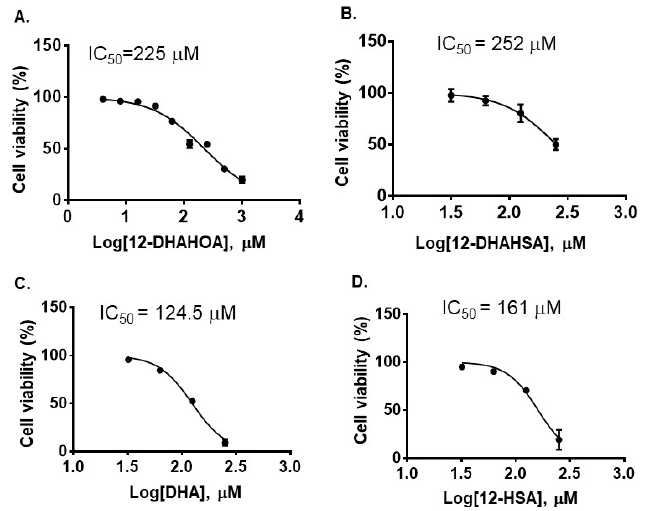
Figure 2. Cytotoxicity of DHA-derived FAHFAs and their free fatty acids. ( A ) 12-DHAHOA, ( B ) 12-DHAHSA, ( C ) DHA and ( D ) 12-HSA (mean ± SD ( n = 6)).